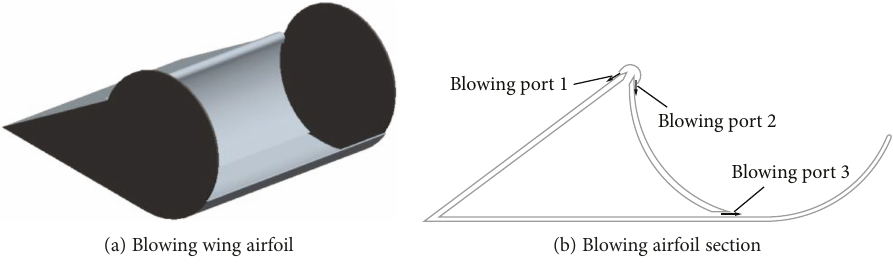
Figure 6: Fan-wing section dimension